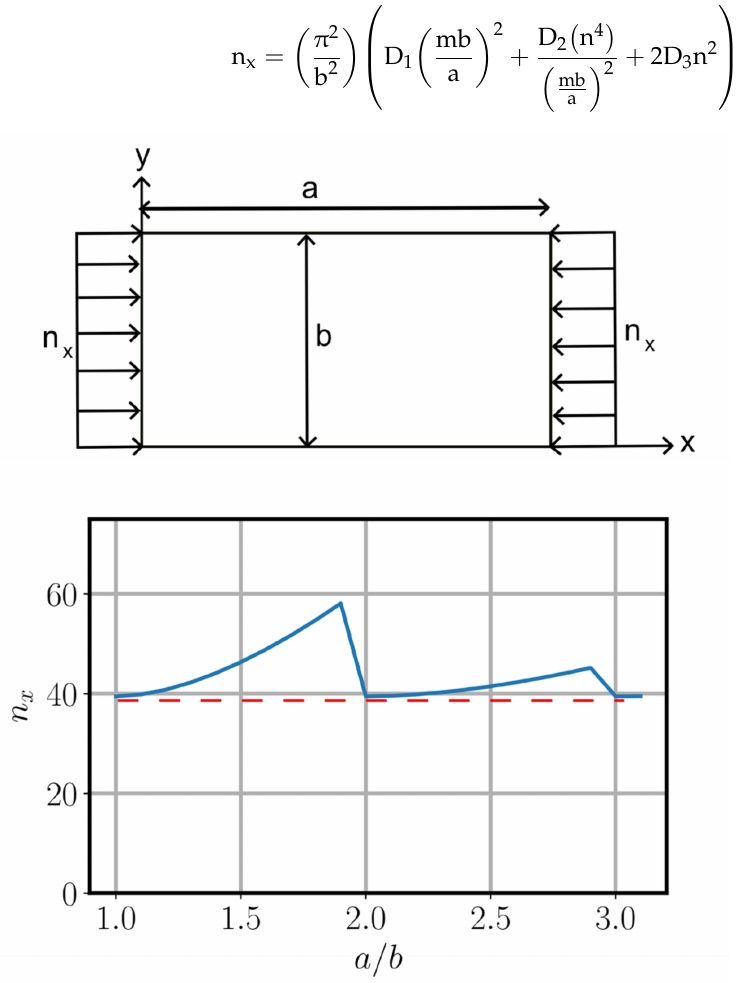
Figure 5. Variation of the critical distributed load for different aspect